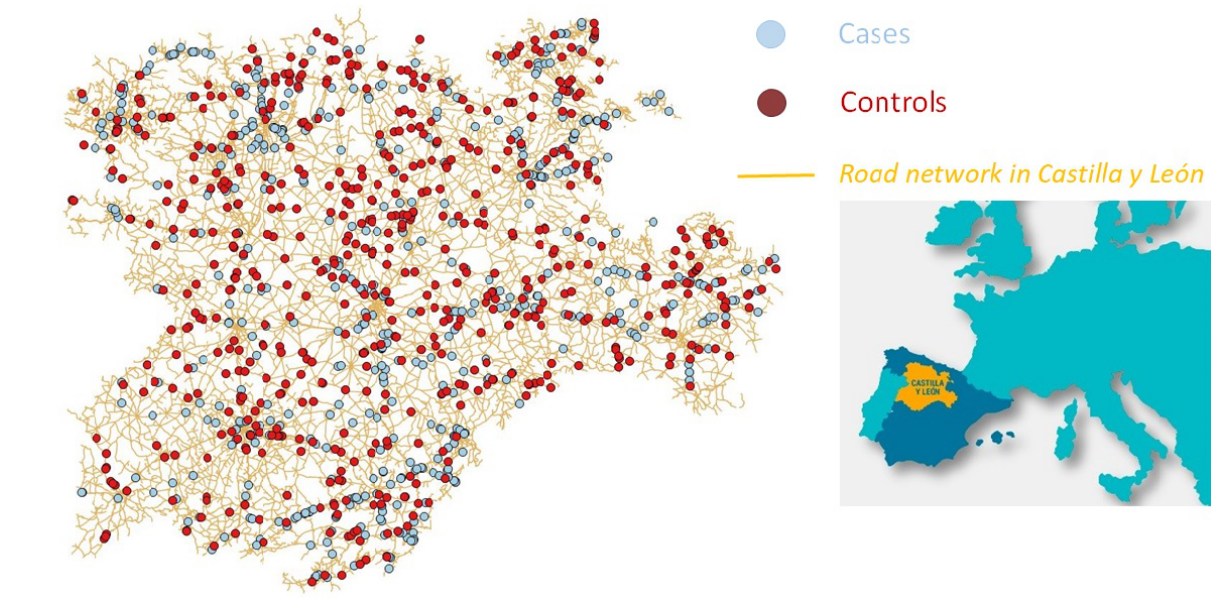
Figure 2. Location of the cases and controls in the road network in the region of Castilla y